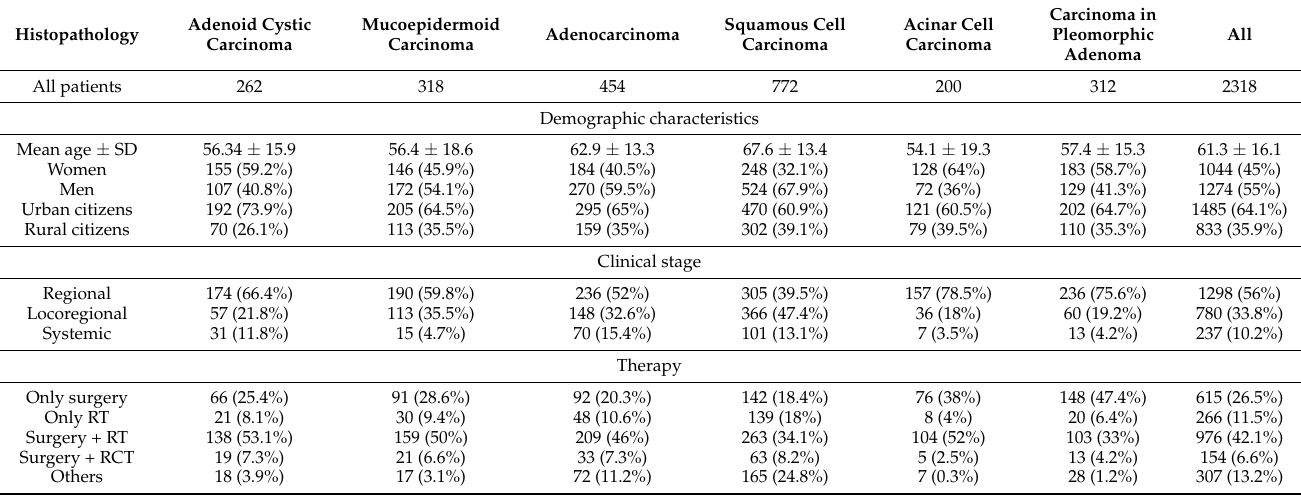
Table 2. Characteristic of different histopathological types of parotid